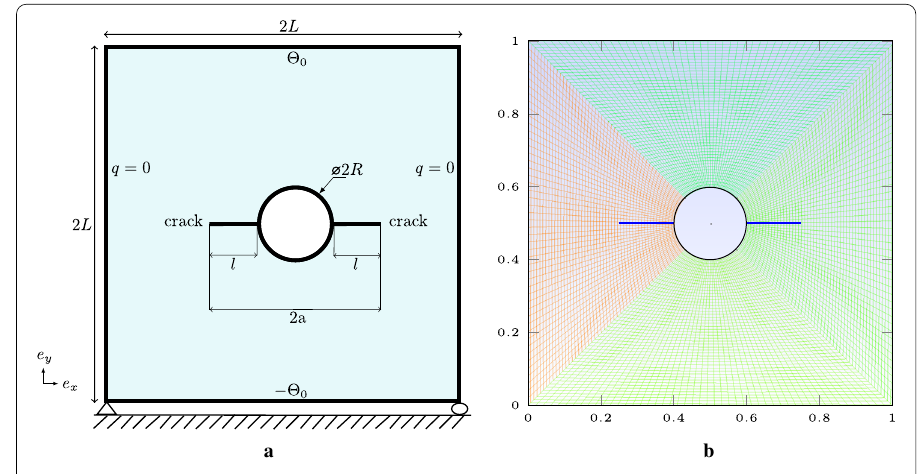
Fig. 11 Square plate with round hole and two cracks: a boundary conditions representation, b structured mesh used